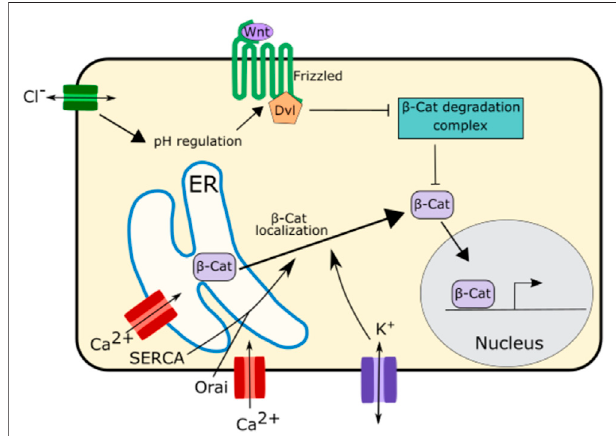
FIGURE 6 | Schematic of mechanisms by which ion channels regulate Wntsignaling. TheERcalciumregulatingchannelsSERCA andOraiaswellas potassium channels regulate the localization and traf fi cking of β -Catenin from the ER to the cytoplasm. This enables β -Catenin to participate in Wnt